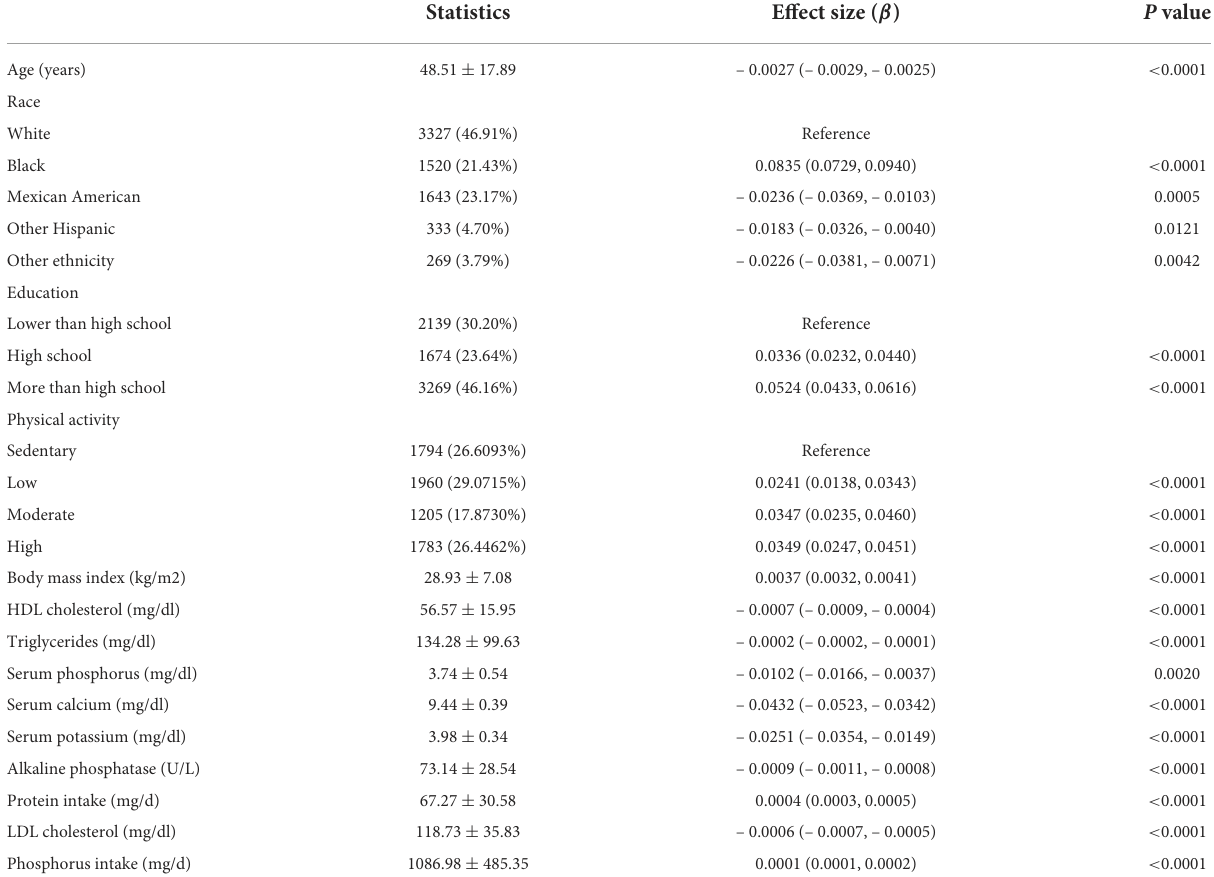
TABLE 2 The result of univariate